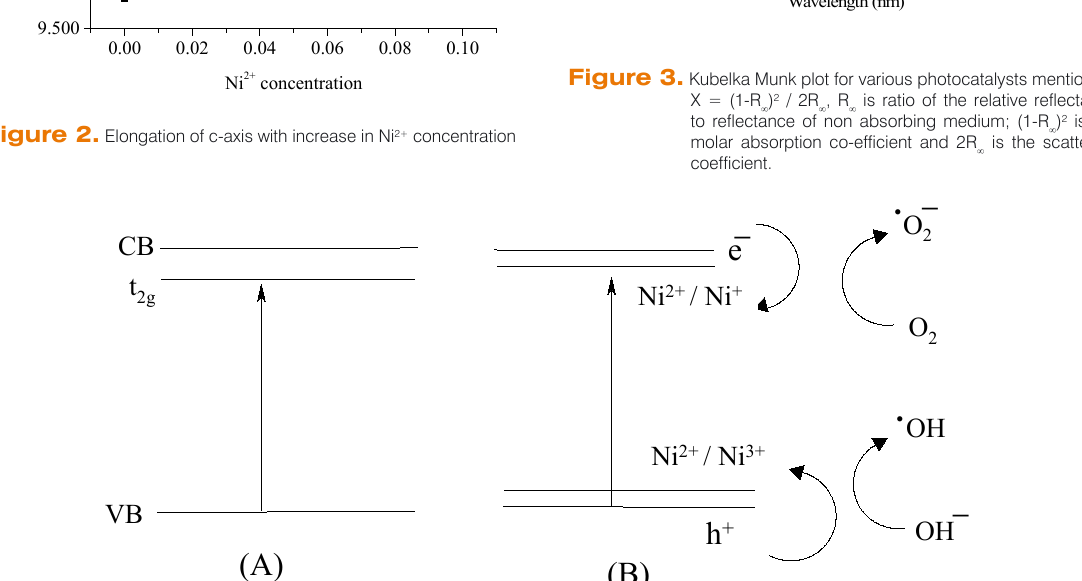
photocatalyst; (B) Trapping and detrapping mechanism in Ni 2+ -TiO 2